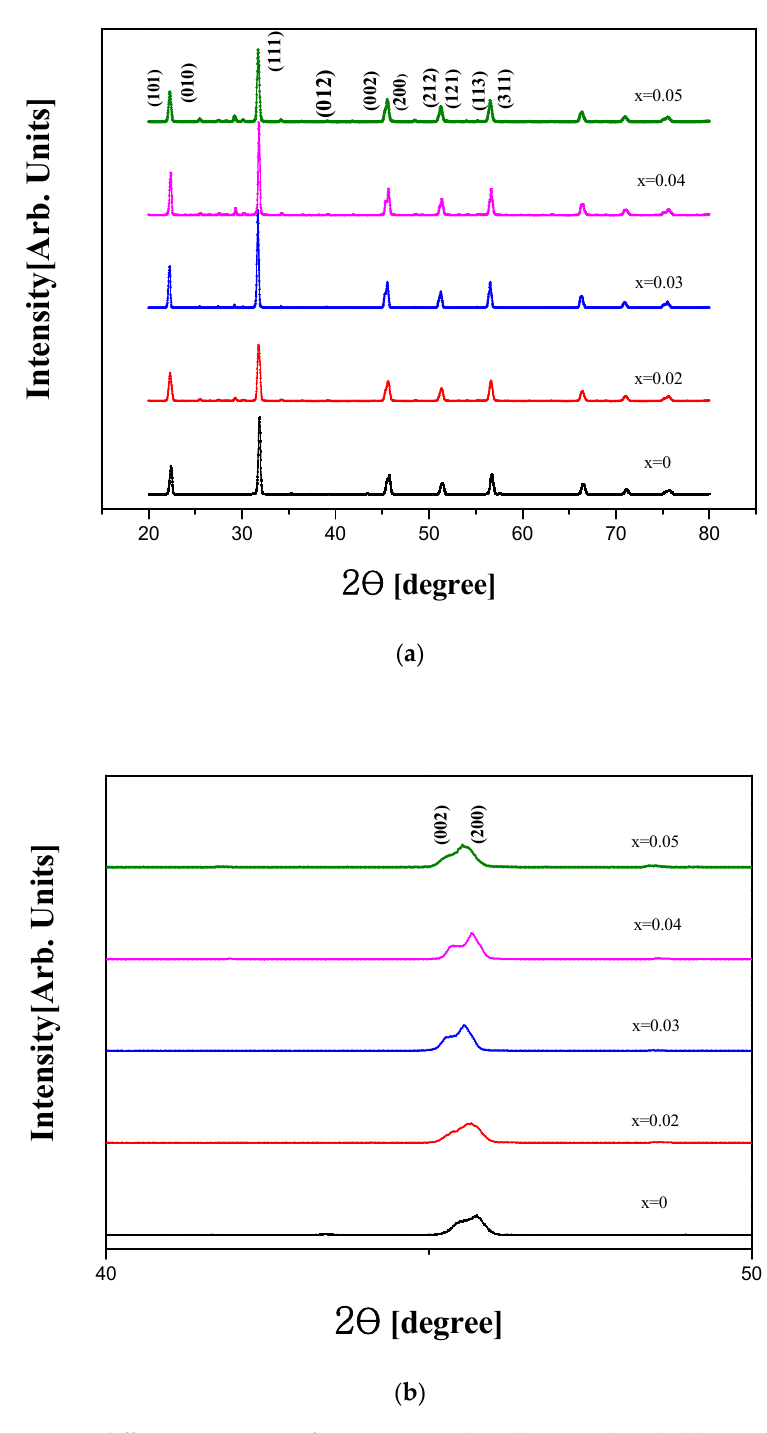
Figure 1. X-ray diffraction patterns of specimens with x. ( a ) 20°–80°; ( b ) 40°–50°. Figure 1. X-ray di ff raction patterns of specimens with x. ( a ) 2 θ = 20 ◦ –80 ◦ ; ( b ) 2 θ = 40 ◦ –50 ◦